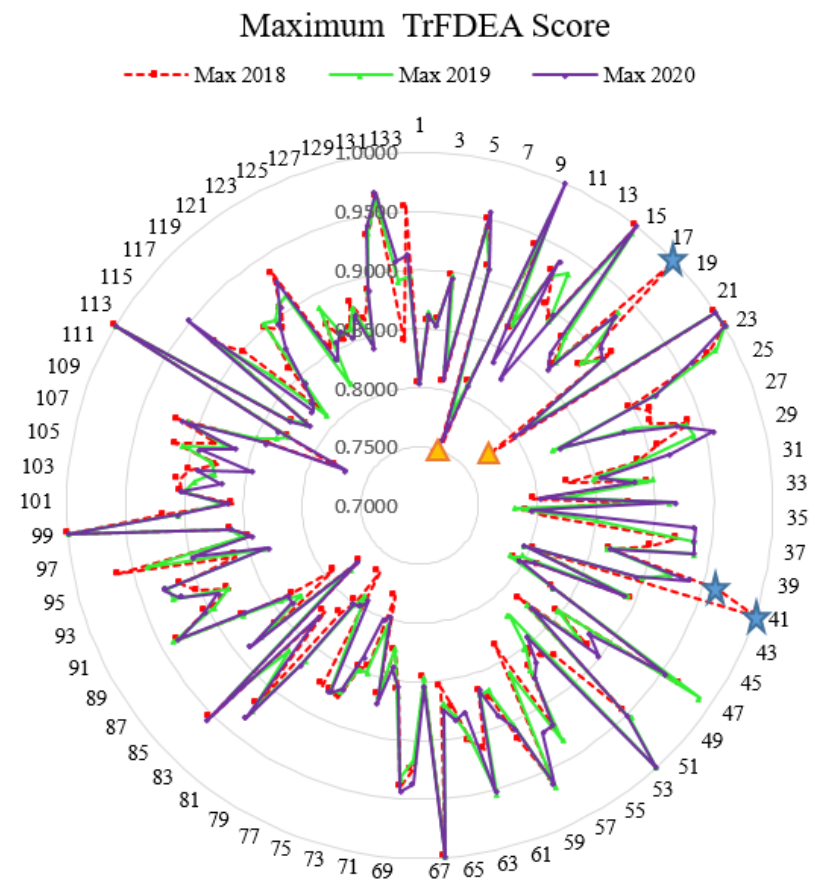
Figure 5. Radar charts of efficiency scores based on Triangular Fuzzy Numbers (TrFNs).